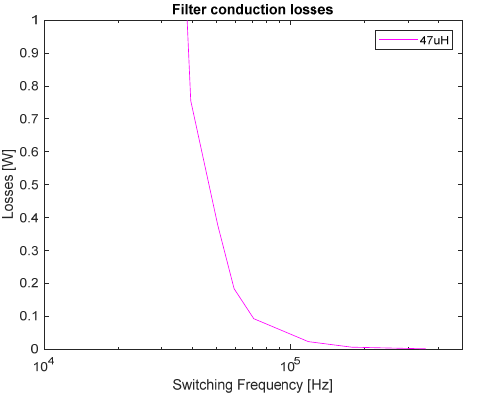
Figure 17. Losses caused by the two filtering inductors depending on the switching frequency in a converter which 2 × 47 µH main inductors. converter which 2 × 47 µ H main